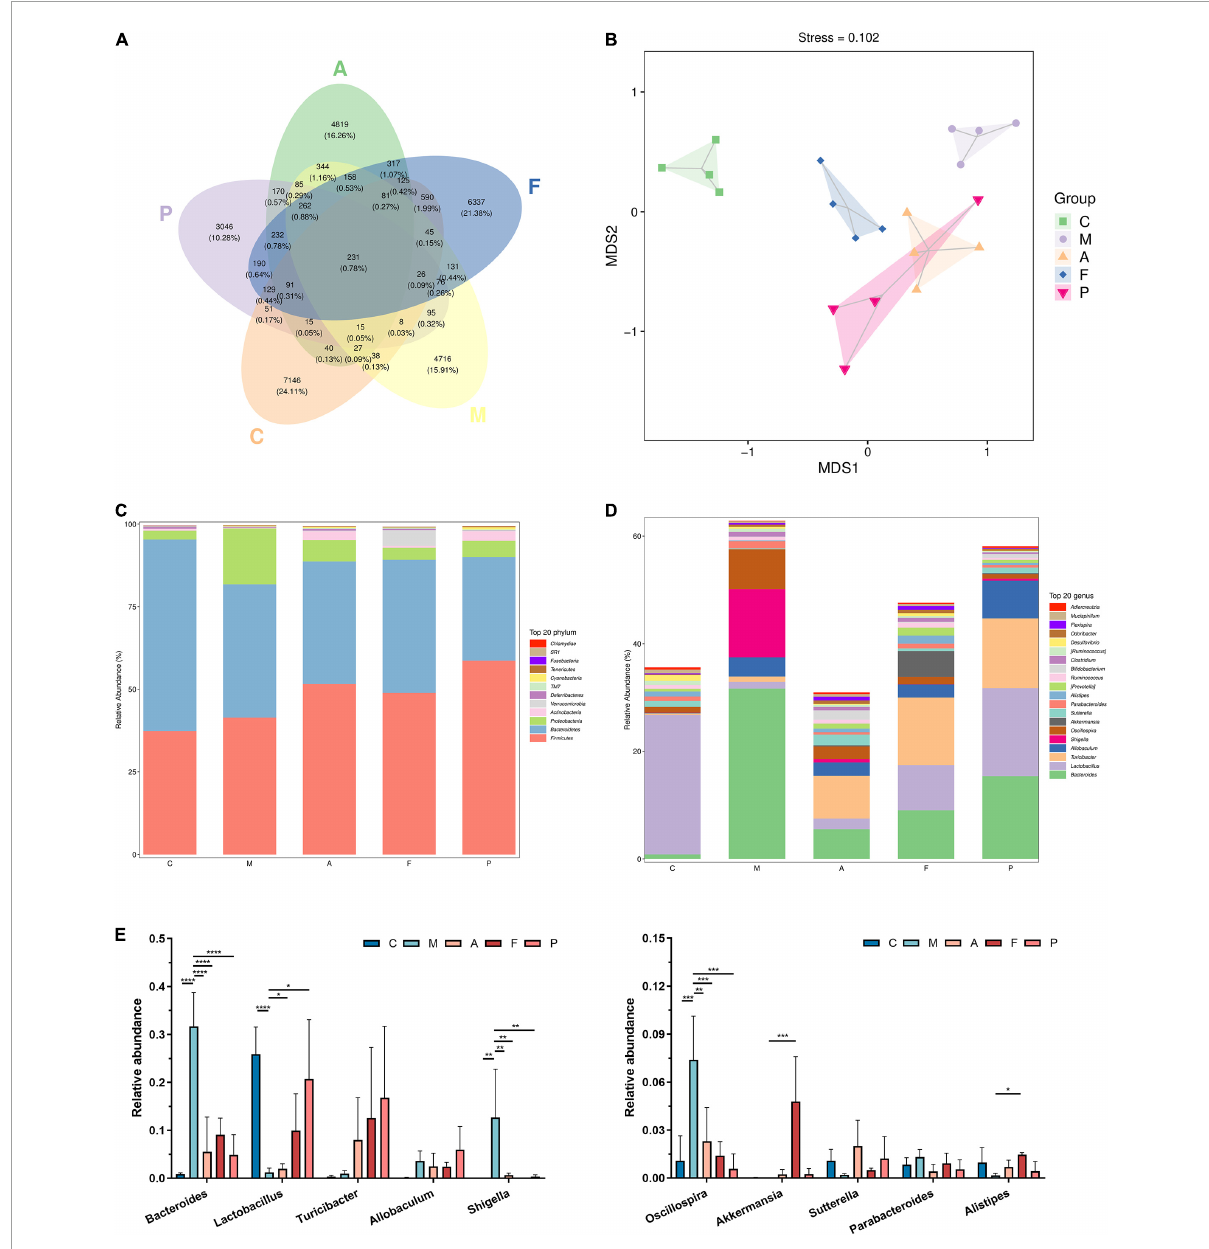
FIGURE3 FA altered the microbial diversity and gut microbiota composition: (A) venn plot that illustrated the observed ASV counts in samples; (B) NMDS analysis based on Jaccard distance; (C) phylum level of the gut microbiota composition; (D) genus level of the gut microbiota composition; (E) relative abundance of the ten most predominant gut microbiota at the genus level ( n = 4). * P ≤ 0.05, ** P ≤ 0.01, *** P ≤ 0.001, and **** P ≤ 0.0001 vs. the M